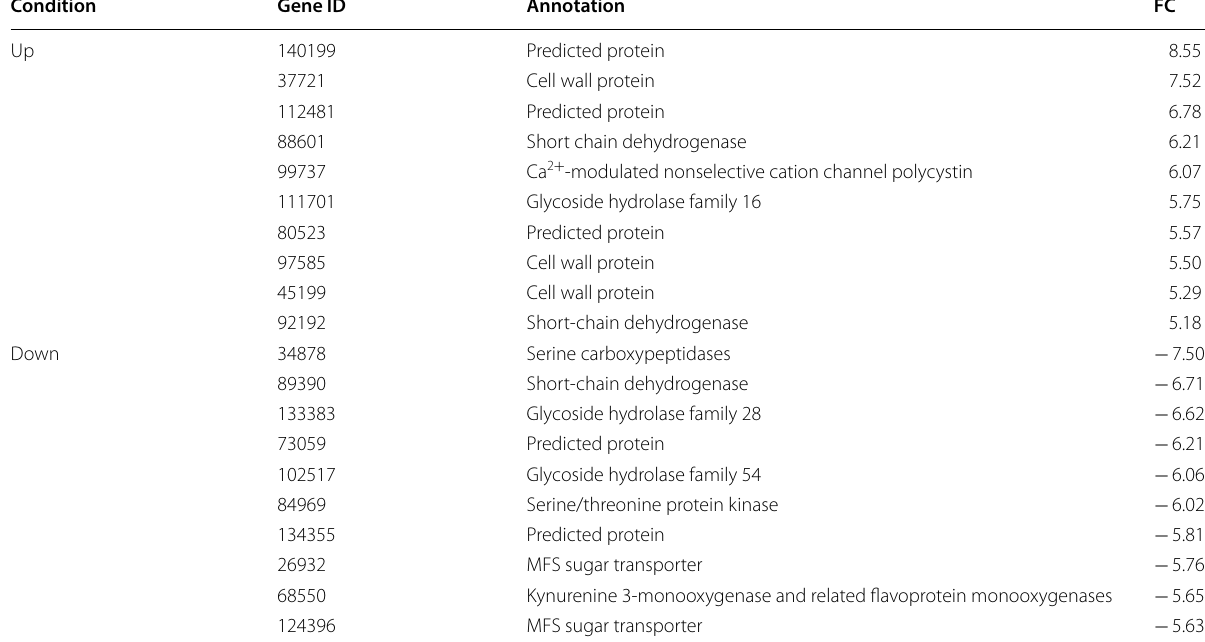
Table 1 Log -fold change (FC) of the top 10 genes differentially expressed in MGD/lactose 2 Condition Gene ID Up